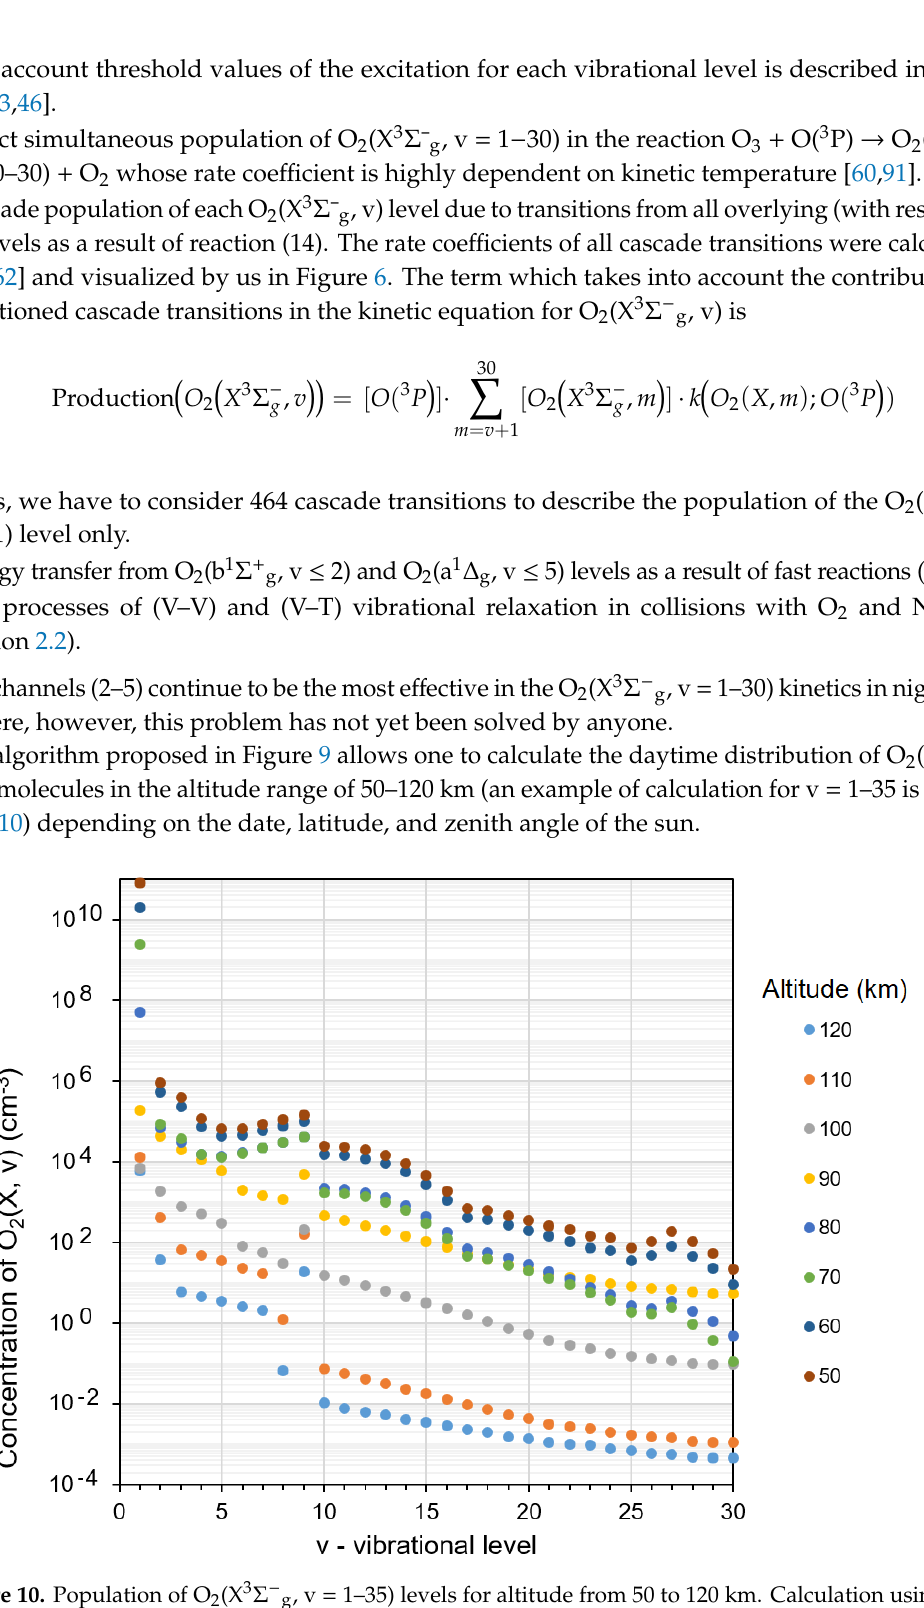
Figure 11. Altitude distributions of O 2 (X 3 Σˉ g , v = 1) (solid curve) and O 2 (X 3 Σˉ g , v = 2) (dashed curve) depending on solar zenith angle. Calculation is for SABER events during the vernal equinox 2002 using YM2011 model.